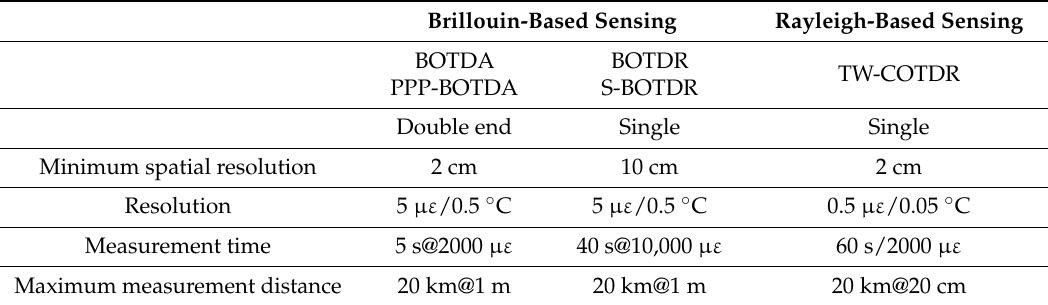
Table 1. Comparison of Brillouin and